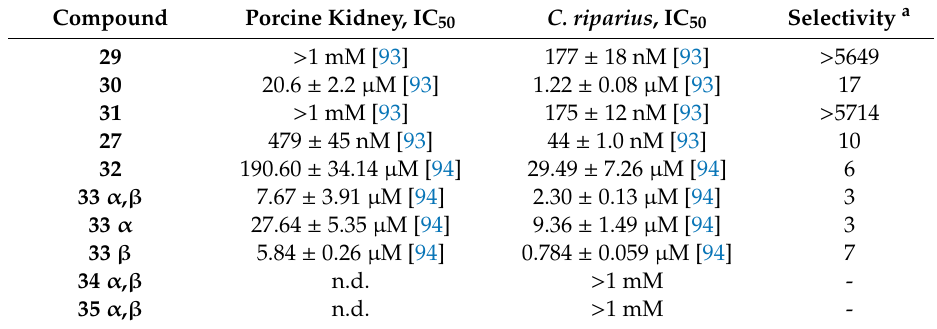
Table 4. Inhibition (IC 50 ) of porcine kidney and C. riparius trehalases by compounds 29 , 30 , 31 , 27 , 32 , 33 , 34 , nd 35